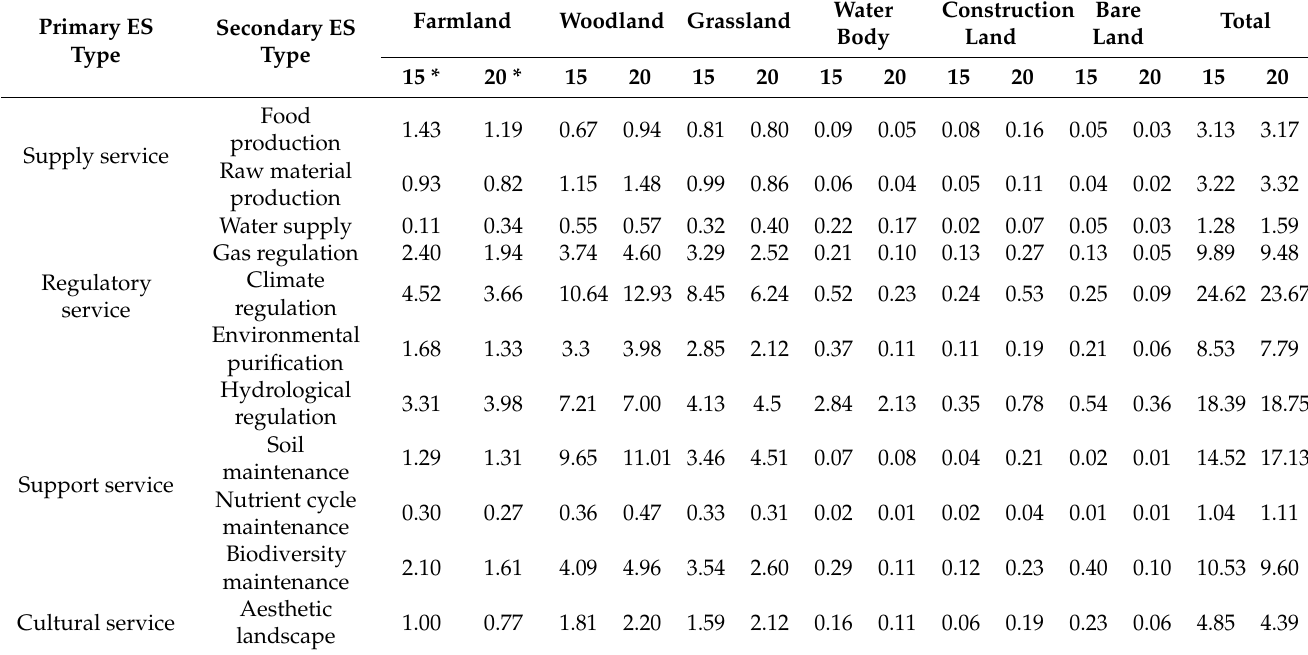
Table 3. The value proportions of 11 specific ESVs of different LULC in 2015 and